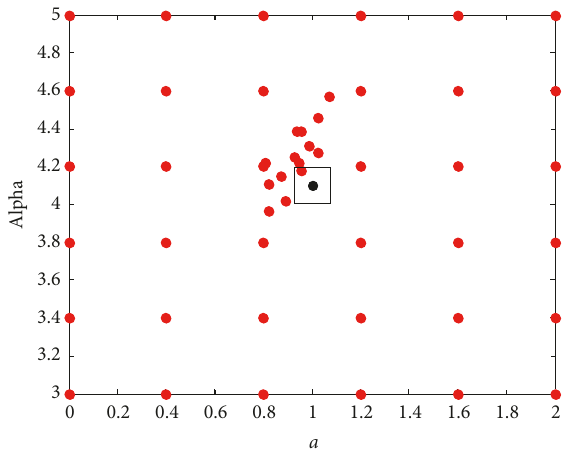
Figure 5: Final population (51 individuals) resulted from MTMED algorithm. The black dot is the optimum